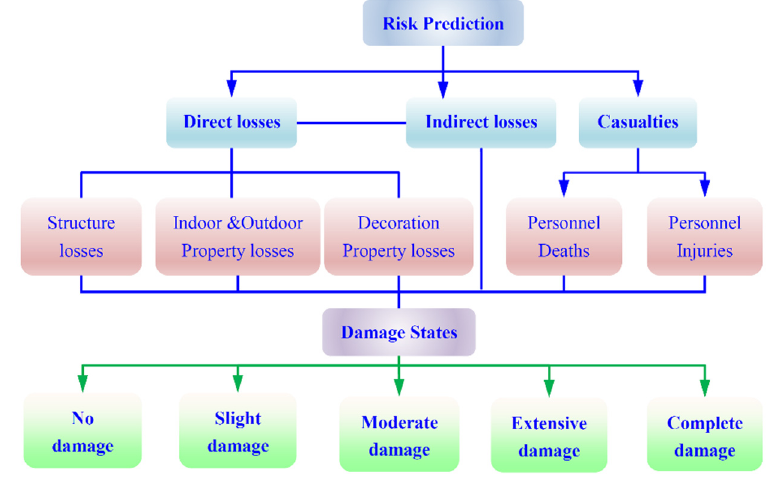
Figure 4. Content structure of OntoBSRA.